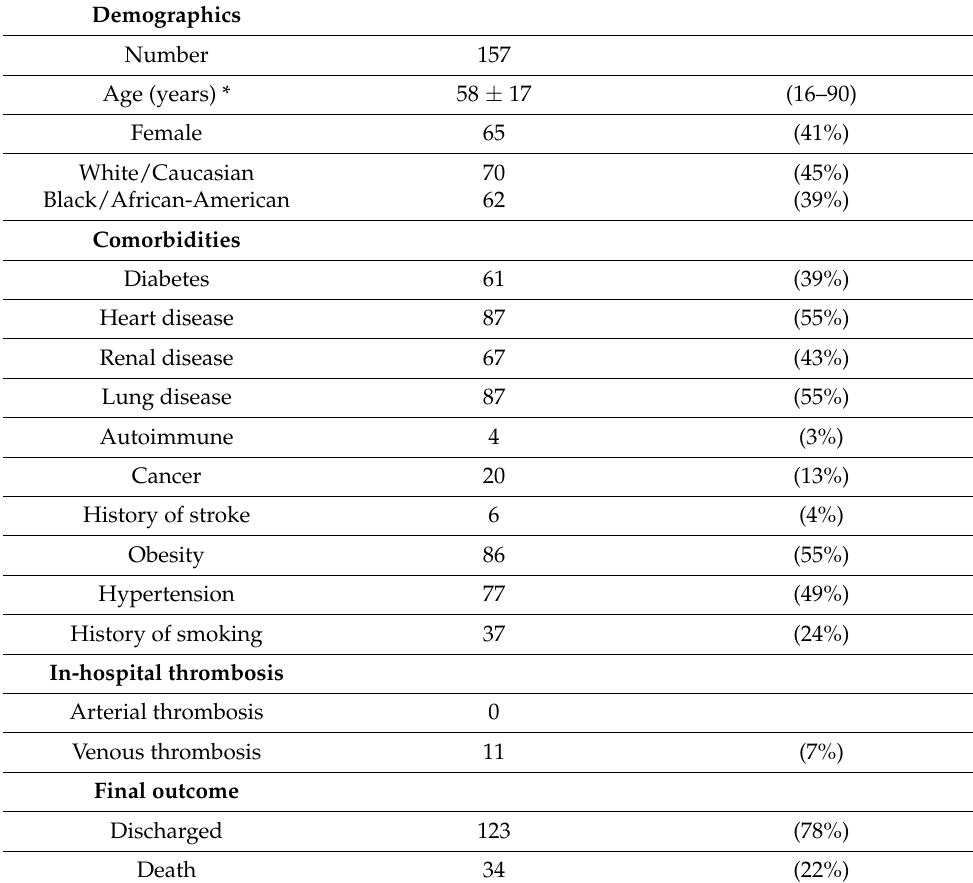
Table 1. Demographic and clinical characteristics of hospitalized COVID-19